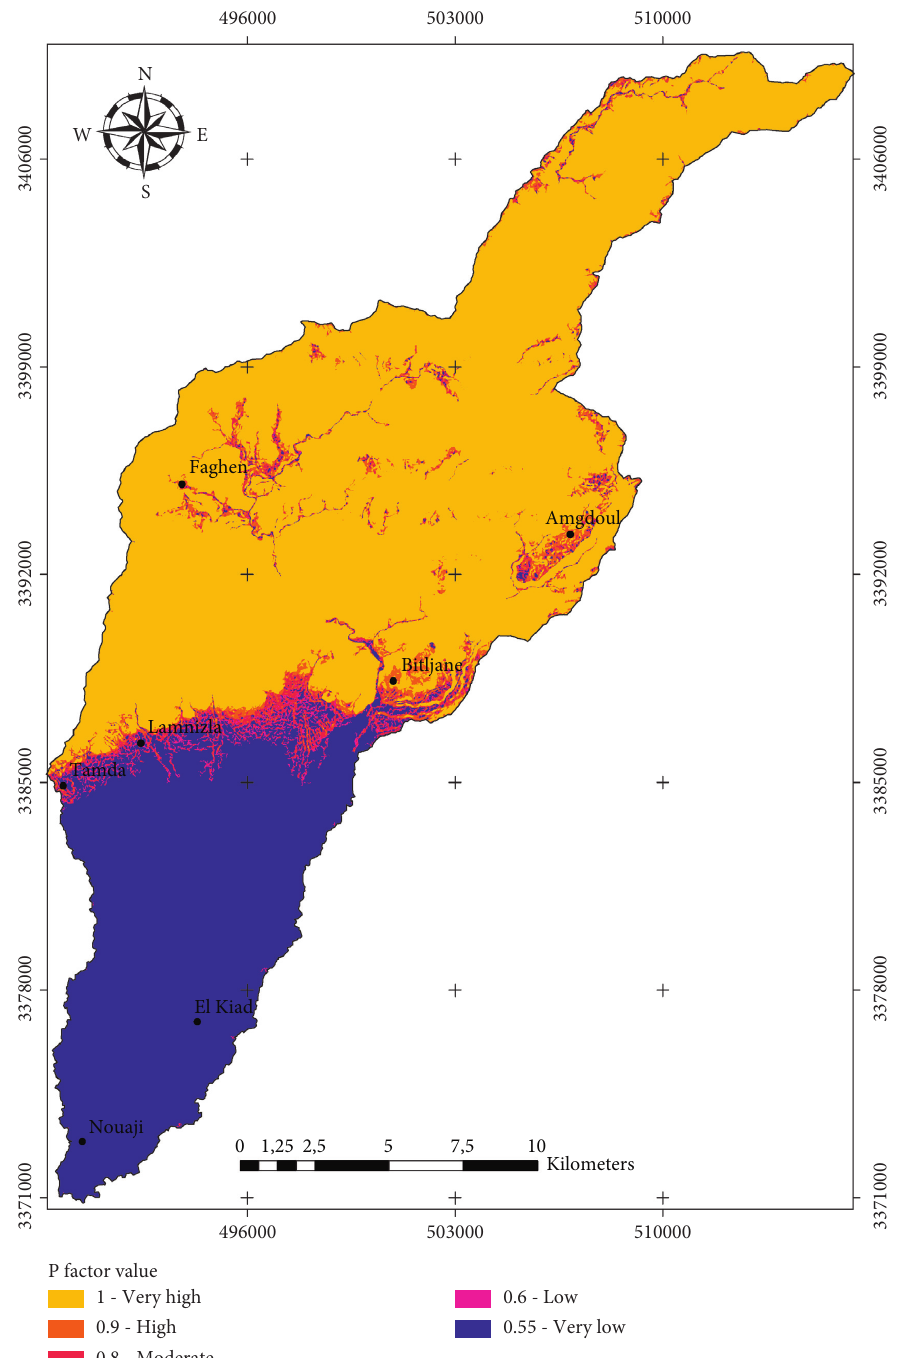
Figure 8: Spatial distribution of support practice factor (P) at Beni Mohand River